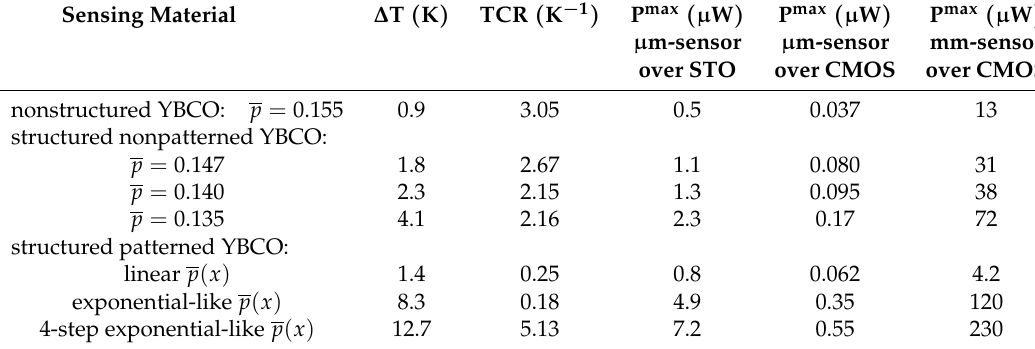
Table 1. Summary of the main operation parameters for resistive high- T c cuprate superconductors (HTS) transition-edge bolometer devices (TES) devices using, as sensing materials, YBCO superconductors with the various doping nanostructurations and patterns explored in this work. These include the usual nonstructured YBCO ( p = 0.155) and the novel options considered by us: structured nonpatterned YBCO ( p ≤ 0.155, Section 4) and structured patterned YBCO (Sections 5 to 7). The ∆ T and TCR follow from the ρ ( T ) curves presented in Figures 1 and 3–5. The P max values were calculated for the three example device implementations described in Sections 2.1.1 and 2.1.2 (microbolometers with direct cooling and SrTiO 3 (STO) or silicon/Yttria-stabilized zirconia (YSZ)/Zirconia (CMOS)-type substrates, plus millimeter-wave sensors using a meander